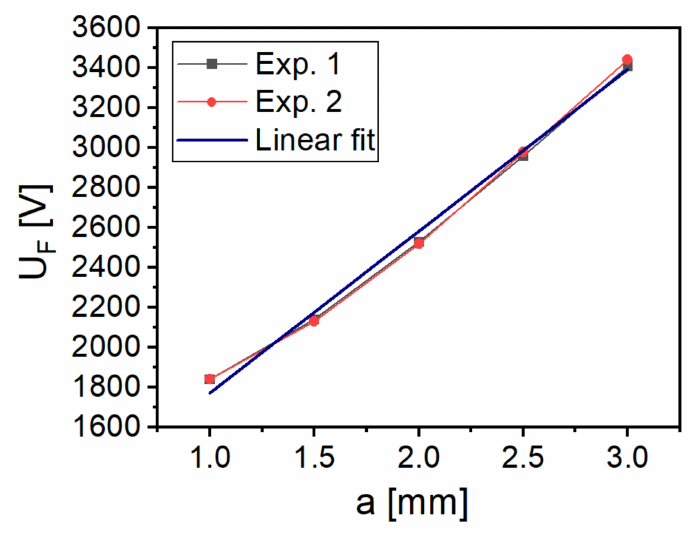
Figure 9. Best focus voltage as a function of Einzel lens